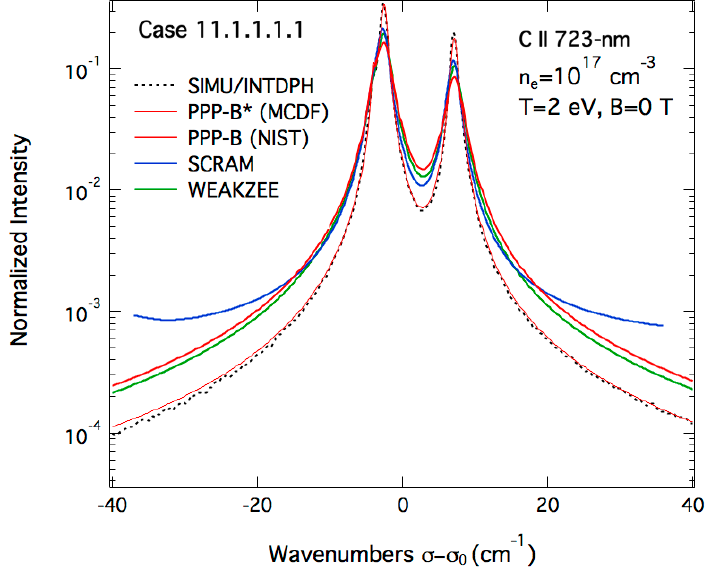
Figure 4. Comparison of synthetic Stark profiles of the C II 723-nm line emitted by a = 10 17 cm − 3 , T = T = 2 eV and B = 0 in a semi-logarithmic scale. The plasma with n e e i dashed line represents the profile obtained with the simulation code SIMU. Note that the profile calculated with INTDPH code is not shown here as it is almost identical to the one obtained with SIMU. The solid thick red line represents the profile calculated with the PPP-B code using the most accurate atomic data provided by NIST while the solid thin red line is the one obtained with the same code PPP-B (PPP-B *) but with atomic data calculated with an MCDF code. Solid blue and green lines represent the profiles obtained respectively with SCRAM (which includes continuum as well as line emission) and